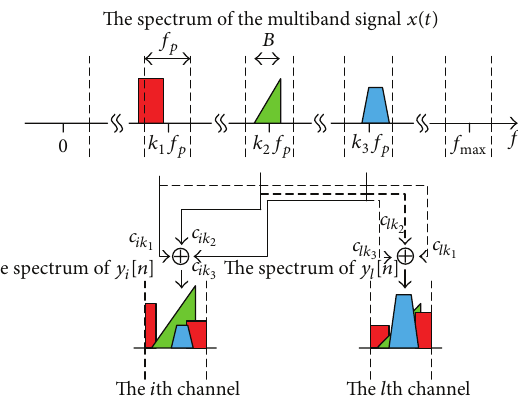
Figure 3: Results of mixing and low-pass